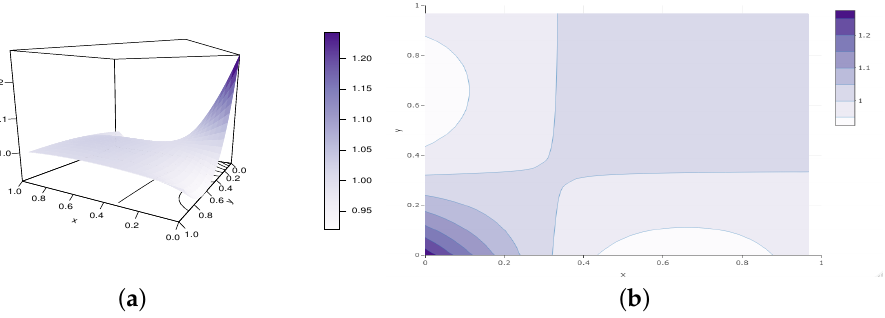
Figure 9. Illustrations of the ( a ) perspective plot and ( b ) contour plot of the SGCC copula density for the following configuration: a = 1/4 and b = c = 2, belonging to Configuration